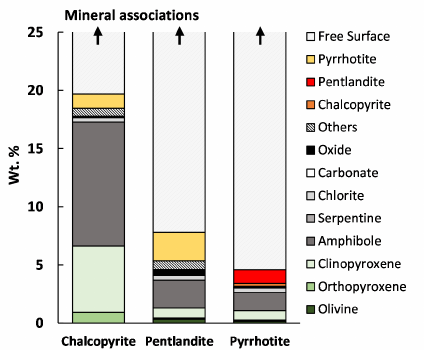
Figure 9. Mineral association in the tailings.